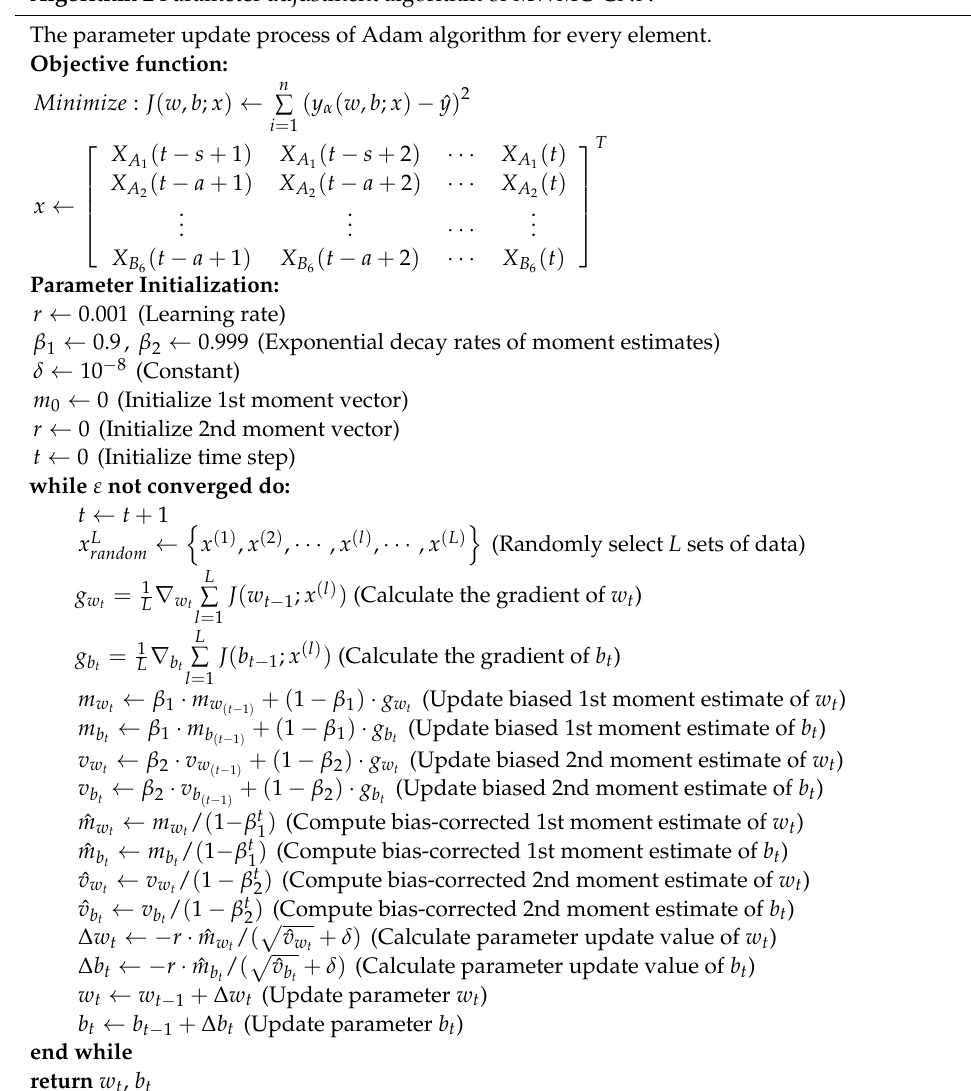
Algorithm 2 Parameter adjustment algorithm of